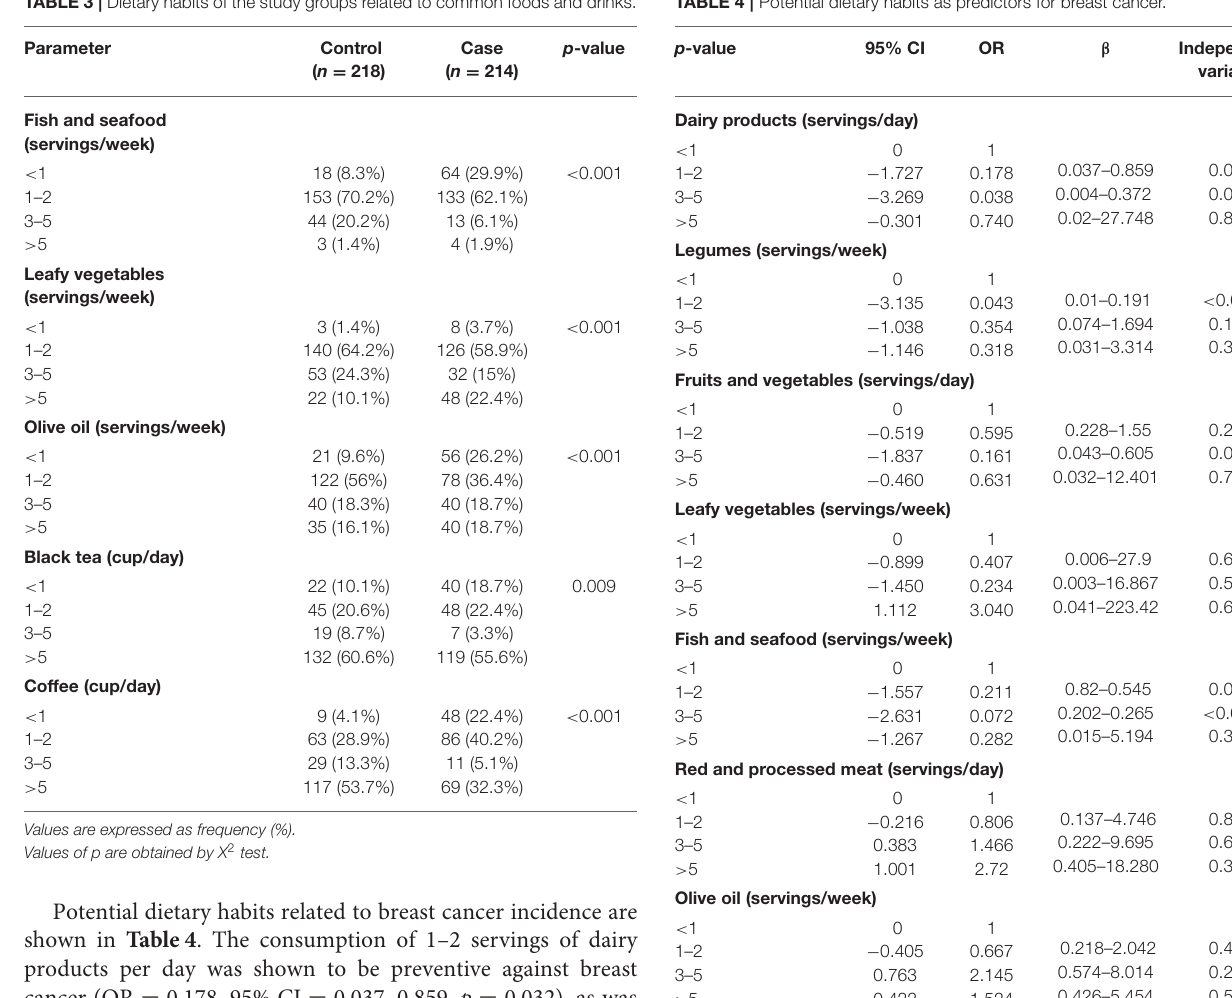
TABLE 3 | Dietary habits of the study groups related to common foods and drinks. TABLE 4 | Potential dietary habits as predictors for breast